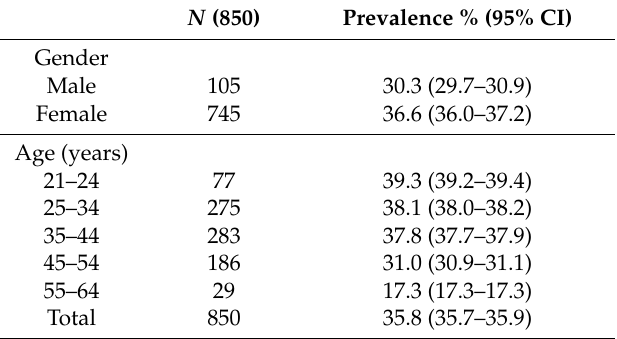
Table 2. Weighted prevalence (95% CI) of past-week depression by gender and age. N (850)